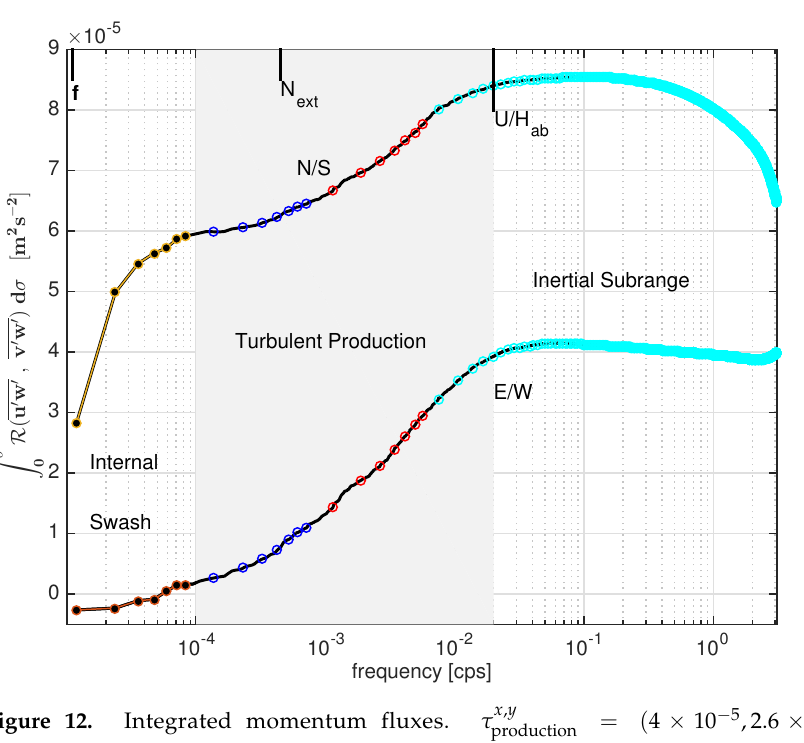
Figure 12. Integrated momentum fluxes. τ x , y